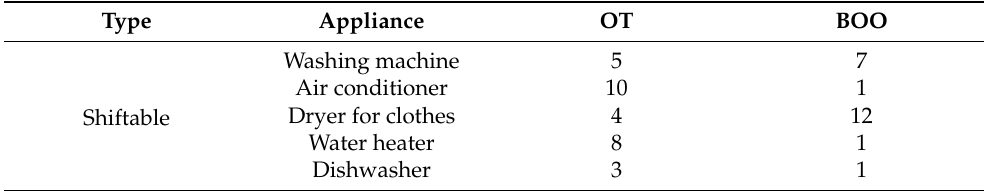
Table 5. The optimized operation times of the appliances in